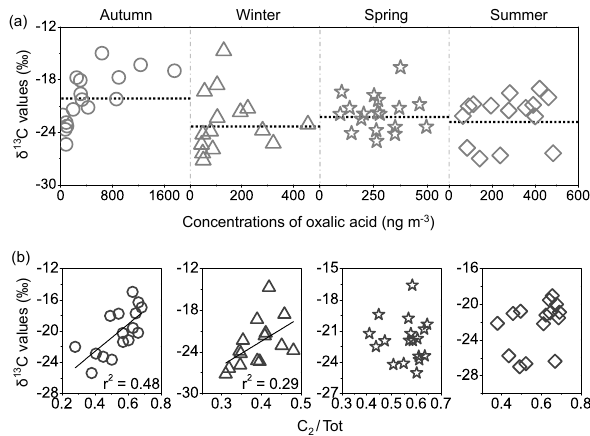
Figure 8. (a) Seasonal variations in the stable carbon isotope ratios ( δ 13 C) of C 2 ; (b) correlations between δ 13 C values of C 2 and rela- tive abundances of oxalic acid to total diacids (C 2 / Tot) in PM 2 . 5 in Beijing. The black dotted lines represent the average δ 13 C values.